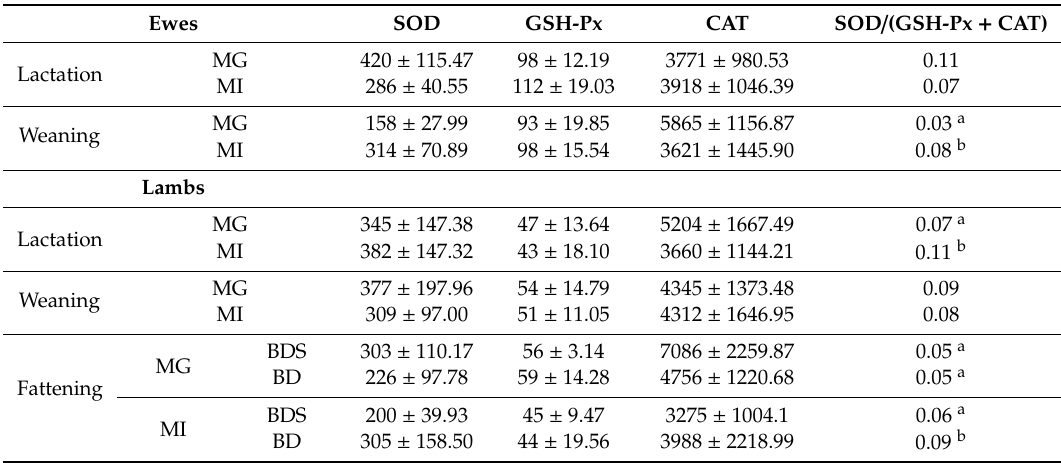
Table 6. Activities of antioxidant enzymes in ewe and lamb blood (EU / g Hb). Ewes SOD GSH-Px CAT SOD / (GSH-Px + CAT) MG 420 ± 115.47 Lactation